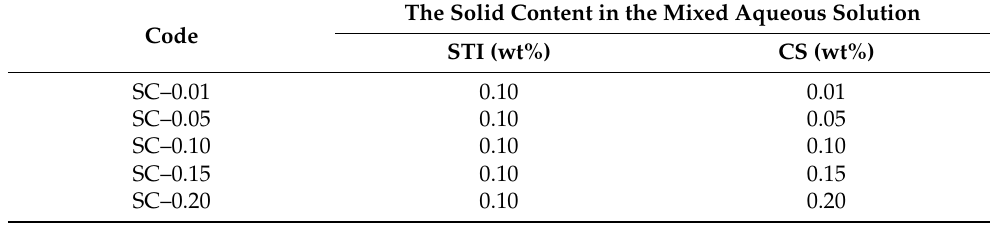
Table 1. Composition of STI–CS